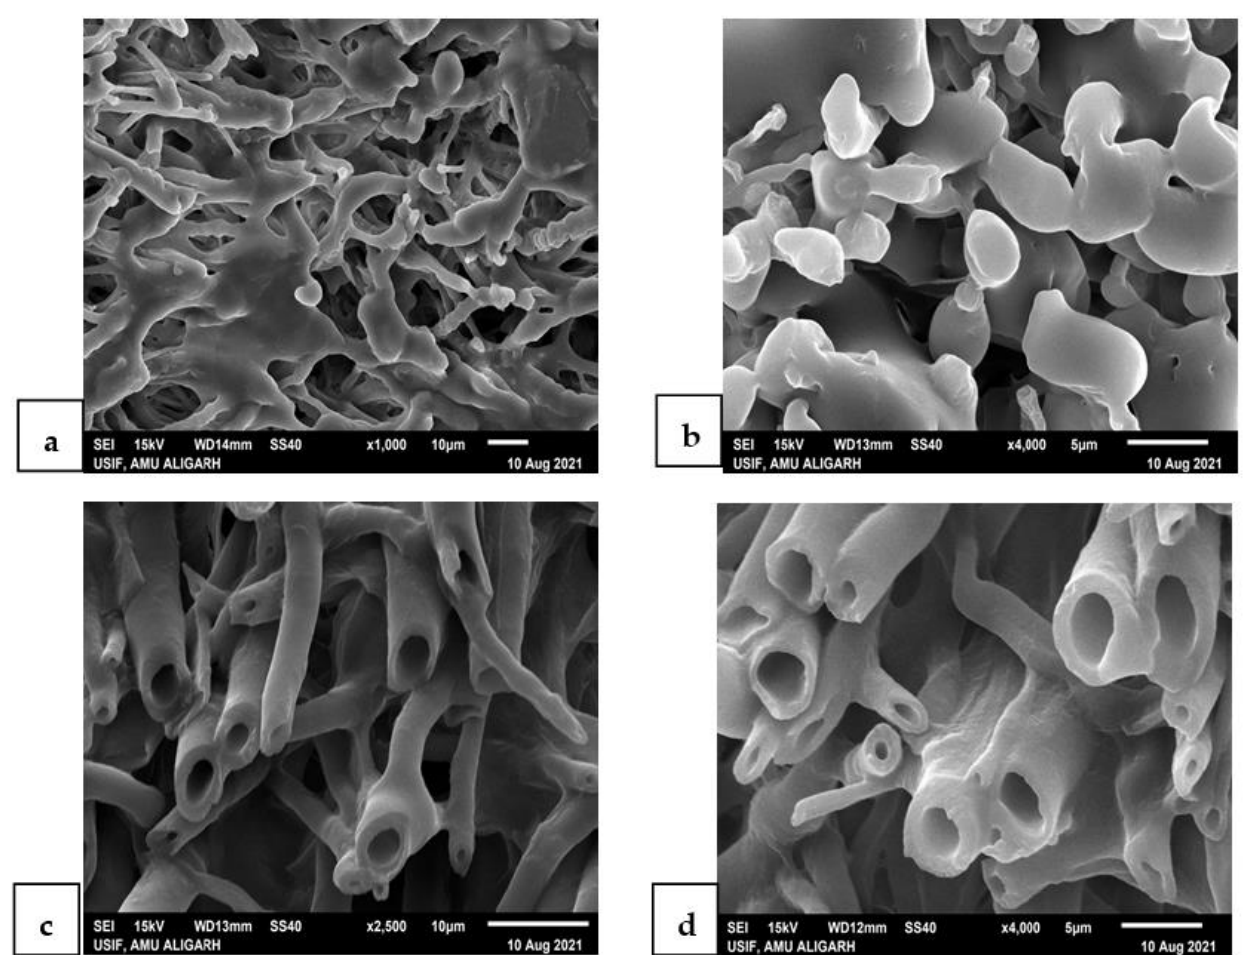
Figure 4. Scanning electron microscopy (SEM) micrograph of ( a , b ) upper body (pileus) and ( c , d ) lower body (stipe) of G. lucidum.